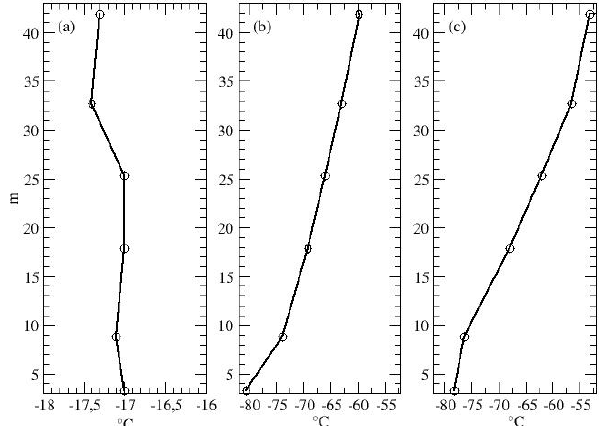
Figure 4. Mean 10-year seasonal cycle of temperature at the six Dome C tower levels. Elevation (legend) is rounded since it changed by almost 0.8m in the course of the 10-year